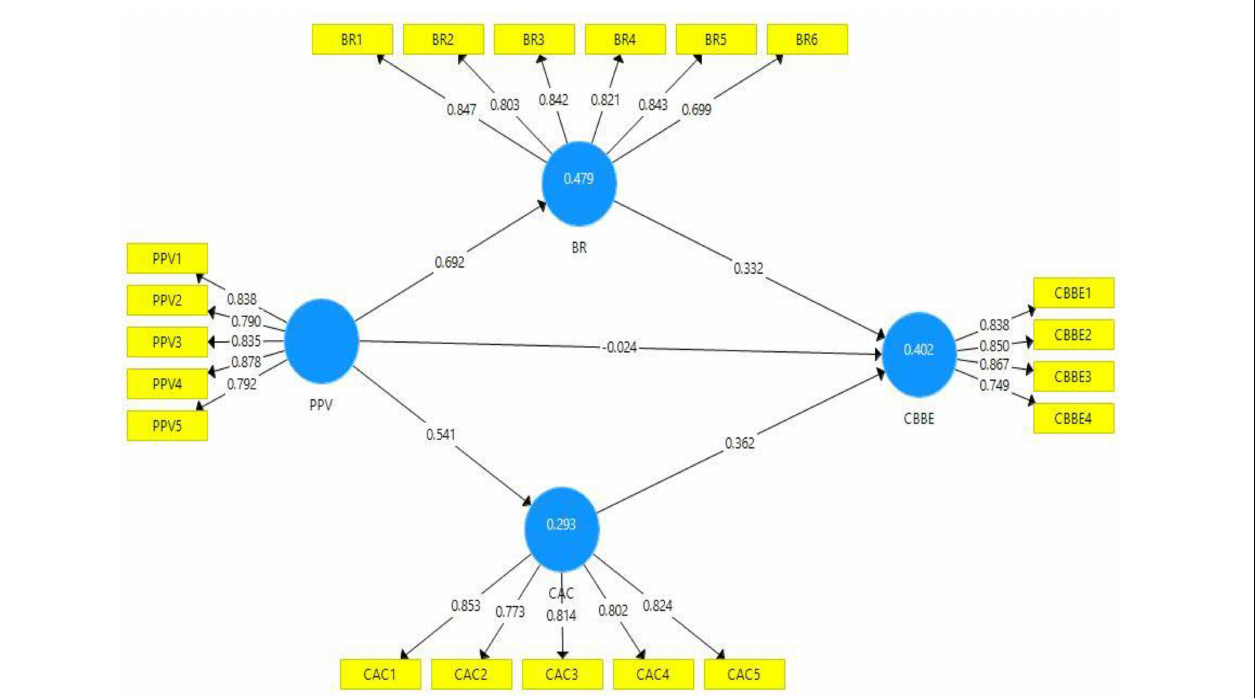
FIGURE 2 | Output of measurement model. PPV = Product Perceived Value, CBBE = Customer-Based Brand Equity, BR = Brand Resonance, AC = Affective Commitment.